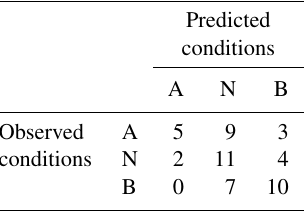
Table 2. Hit–miss matrix with three equal categories: above-normal (A), near-normal (N), and below-normal (B) precipitation.